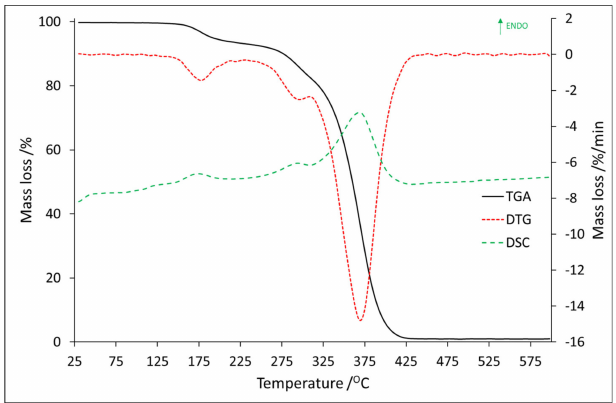
Figure 8. The TG/DTG–DSC curves for Tb:2,6-DClB/PMMA.